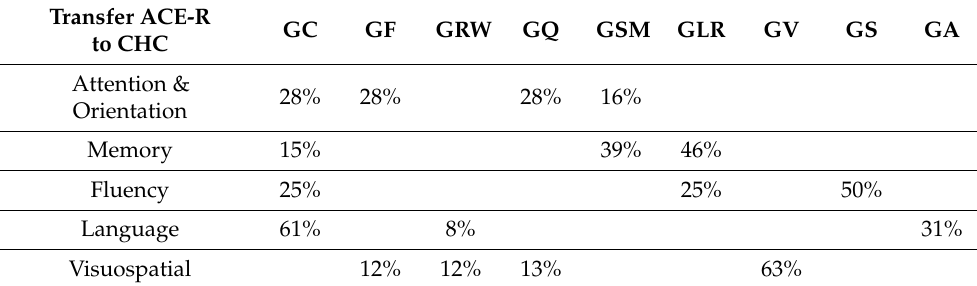
Table 3. Transfer of the CHC domains according to the modified ACE-R factor analysis.